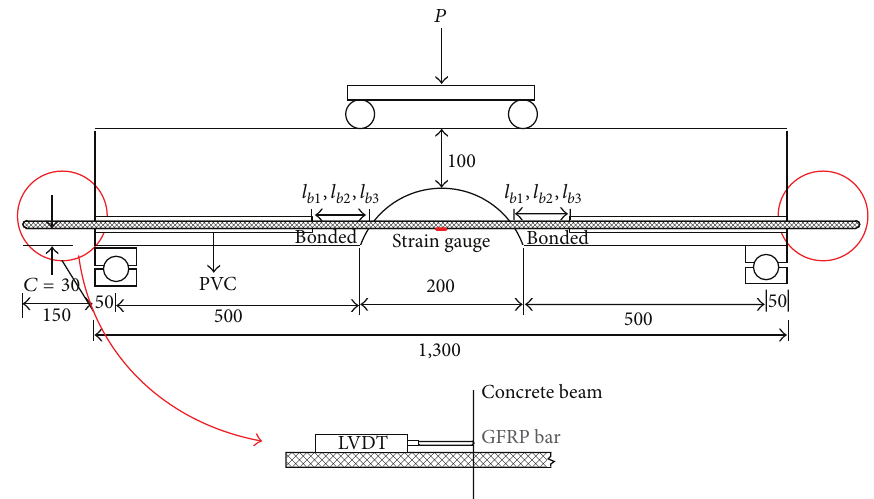
Figure 2: Specimen geometry of the BS beam test.